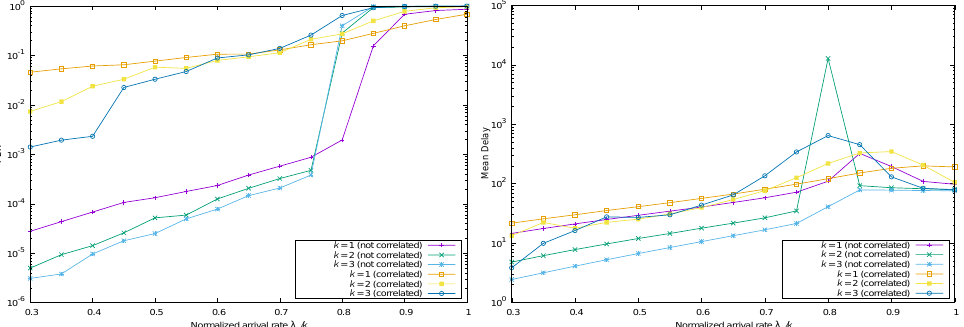
Figure 13. Simulated PLR ( left ) and Mean Delay ( right ) for FA-CSA versus λ a / k , with Λ ( x ) = 0.86 x 3 + 0.14 x 8 , n = 200 and k = { 1,2,3 } , and correlated arrivals ( H = 0.75 and r 1 = 0.5) with marginal Poissonian